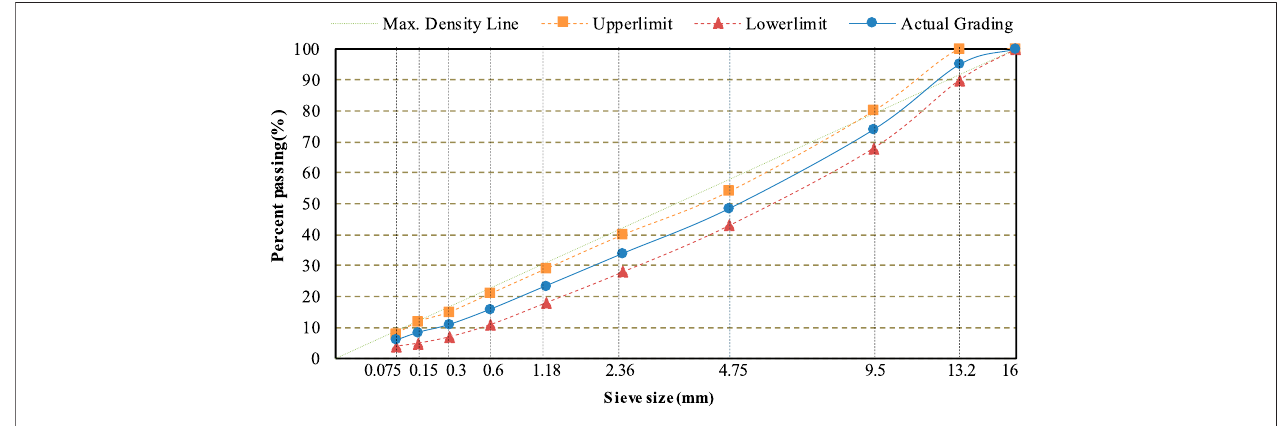
FIGURE 1 | Design grading envelope of AC-13C asphalt mixture.